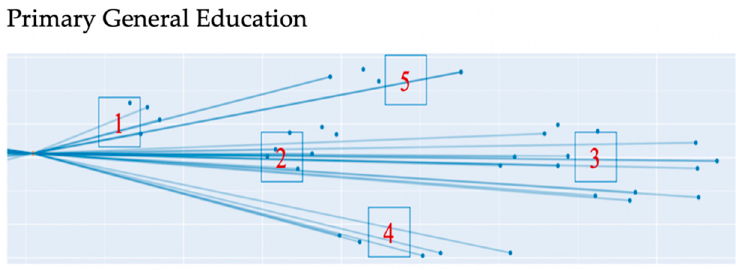
Figure 9. Semantic cluster “Sports games components for physical